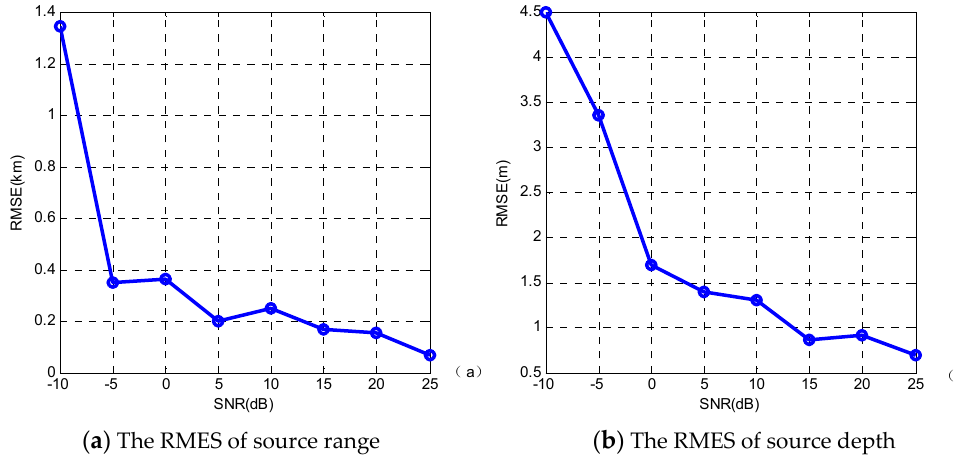
Figure 8. RMSE of different SNRs over the 50 simulations.